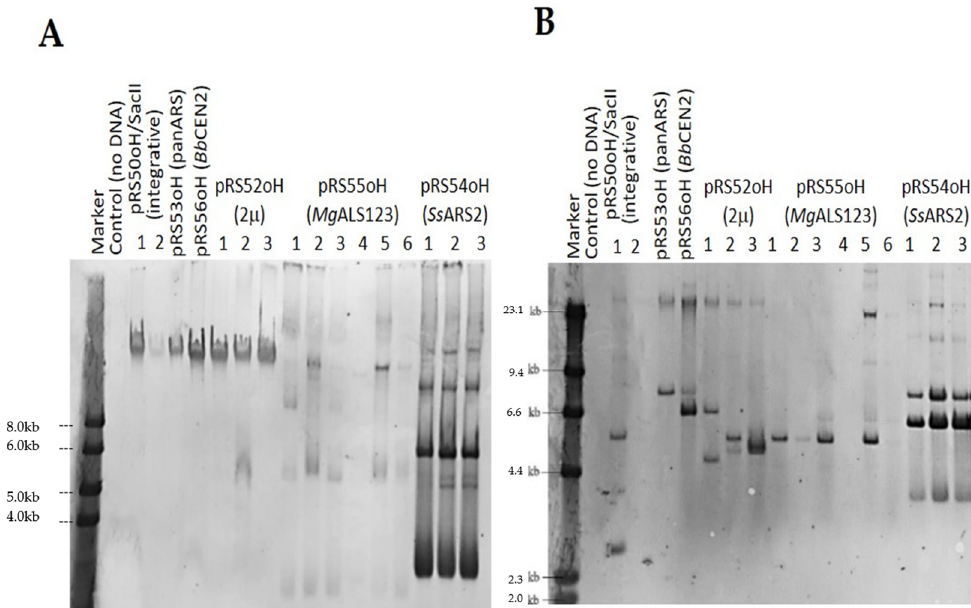
Figure 4. Typical results of molecular analysis by Southern blotting of undigested ( A ) and digested ( B ) DNA isolated form transformants of S. polymorphus var. africanus . ( B ) DNA isolated form transformants of S. polymorphus var. africanus